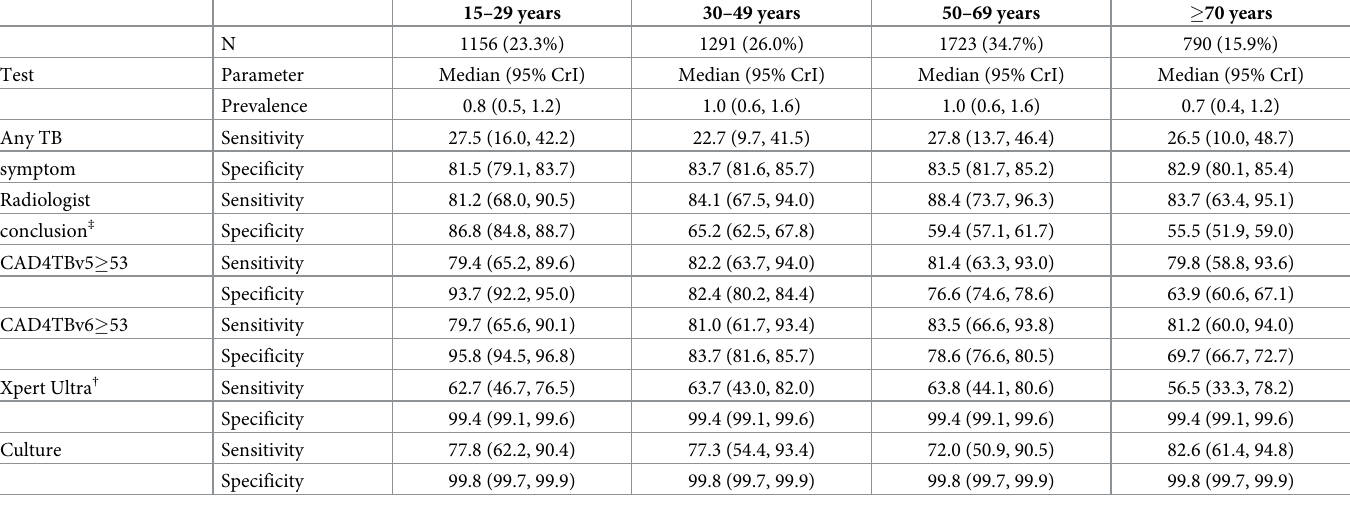
Table 5. Age, sex and HIV adjusted posterior median and 95% credible intervals (95% CrI) of PTB prevalence and diagnostic test sensitivity and specificity for Vukuzazi dataset presented by age